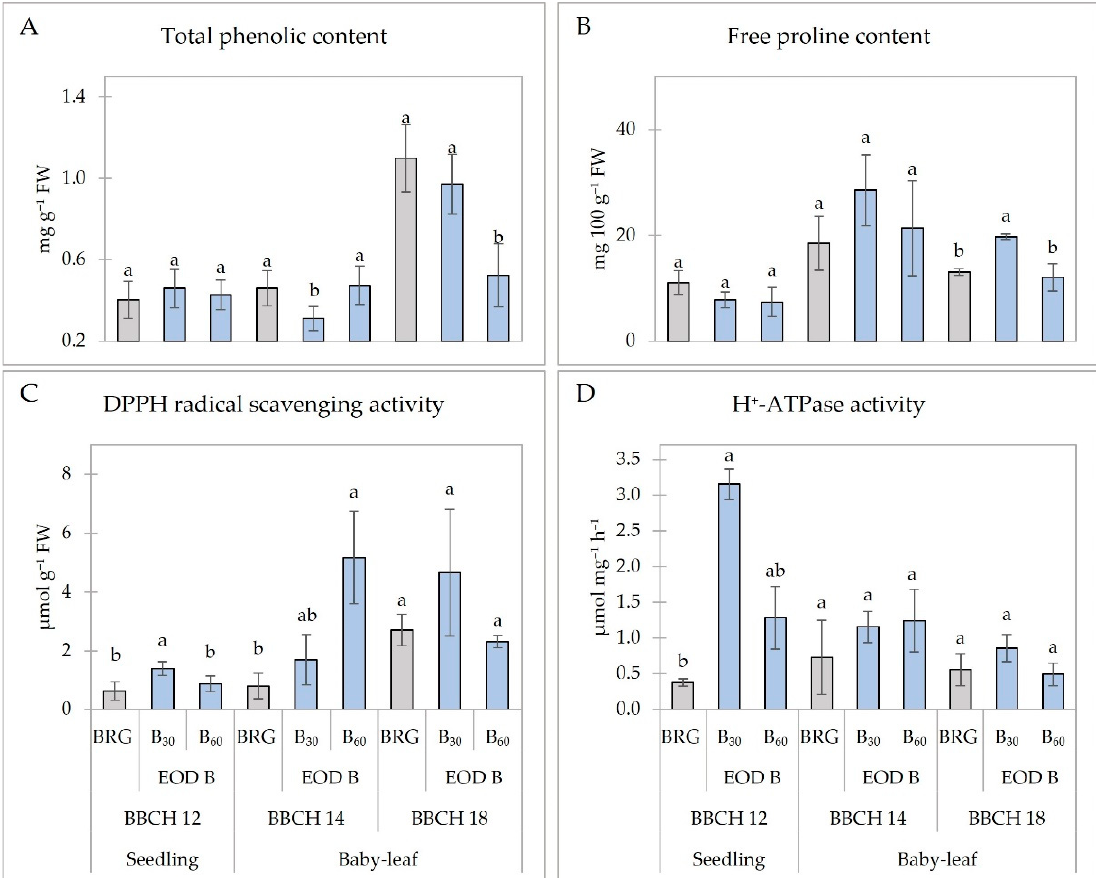
Figure 4. Metabolic response (( A ) total phenolic content; ( B ) free proline content; ( C ) DPPH radical scavenging activity; ( D ) H + -ATPase activity) of lettuce plants at different development stages. BRG , 5% blue (peak = 450 nm), 85% red (peak = 660 nm), 10% green (peak = 530 nm) light for 16 h d –1 (Control; from 06:00 to 22:00); B 30 and B 60 , PPFD of end-of-day lighting with blue light (peak = 450 nm) at 30 and 60 µmol m –2 s –1 , respectively; EOD, end-of-day lighting for 4 h d –1 (from 22:00 to 02:00); PPFD, photosynthetic photon flux density; DPPH, 2,2-diphenyl-1-picrylhydrazyl. Data are means of two replications with three samples per replication (n = 6). Means with different letters are significantly different from the control treatment (BRG) at p < 0.05.